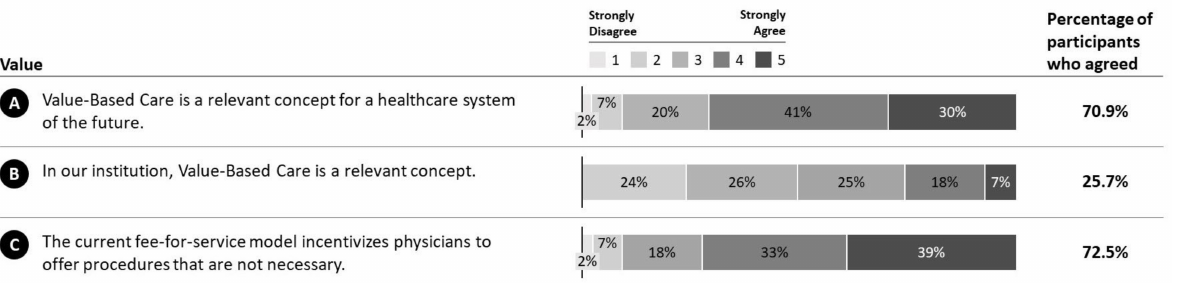
Figure 4. Category value. Responses of participants along for the VBC category value. A : Relevance of VBC for the healthcare system. B : Relevance if VBC for own institution. C : Incentive for unnecessary procedures through fee-for-service